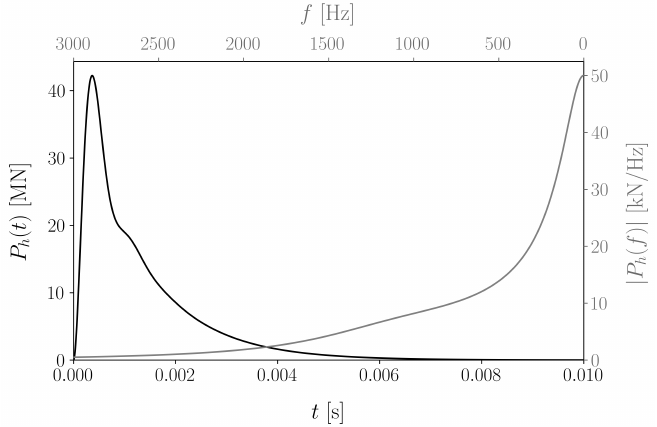
Figure 4. Hammer force function P h ( t ) (in black) and the amplitude of its Fourier transform | P h ( f ) | (in grey) for a pile with R p = 1.1 m and h p = 0.03 m.